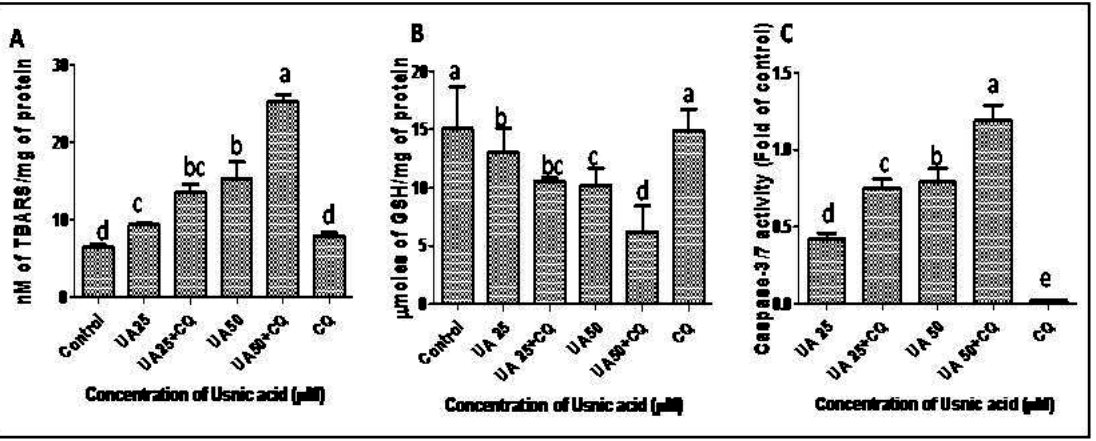
Figure 8. Effect of UA on HeLa cells in the presence or absence of chloroquine after 24 h of treatment; ( A ) increase in lipid peroxidation; ( B ) depletion of reduced glutathione (GSH); ( C ) caspase 3/7 activity. Values are the means ± SD of three independent experiments. Means sharing different letters differ significantly from each other at p ≤